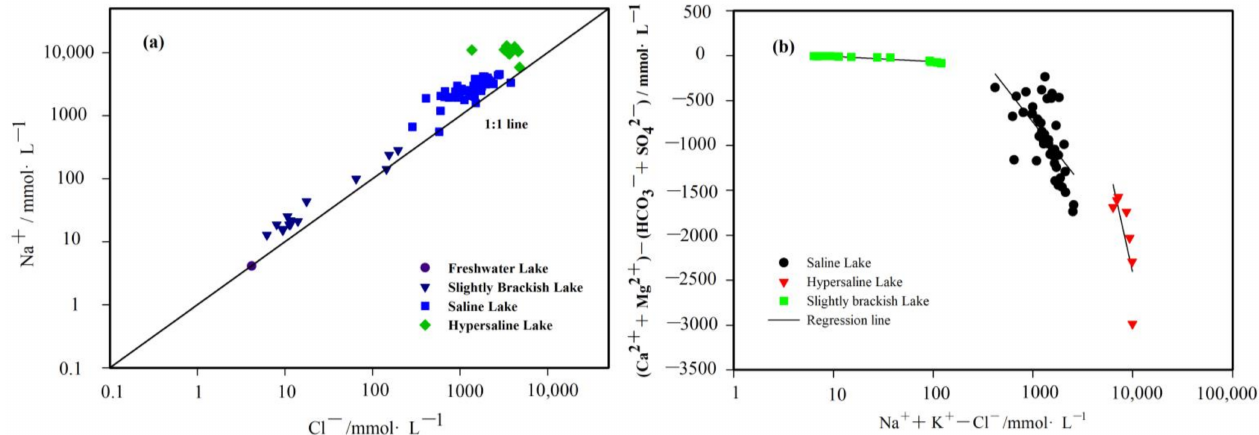
Figure 5. The relationships between ( a ) Na + and Cl − and ( b ) (Ca 2+ + Mg 2+ ) − (HCO 3 − + SO 42 − ) and Na + + K + − Cl − .